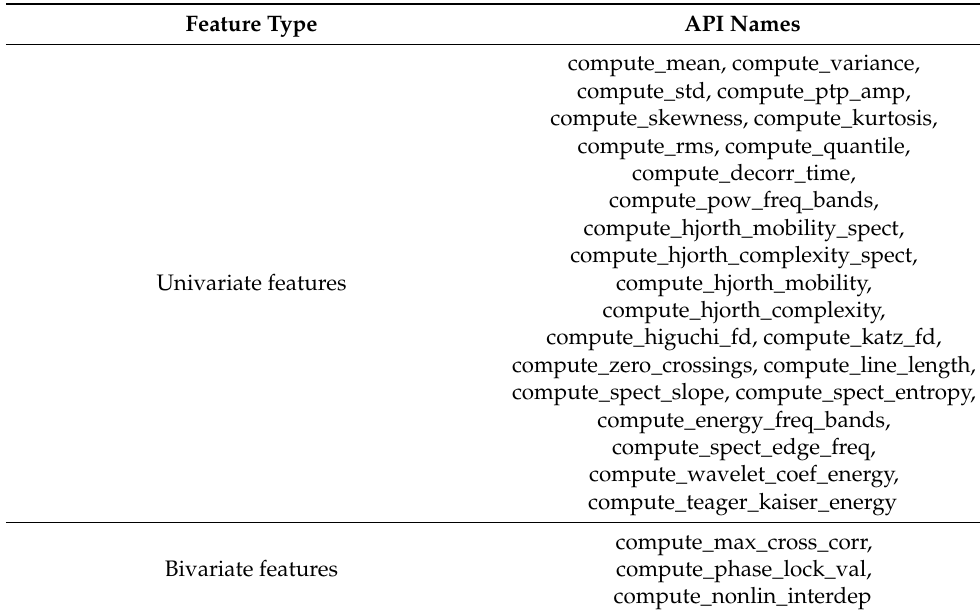
Table A2. List of 27 APIs used to extract the signal